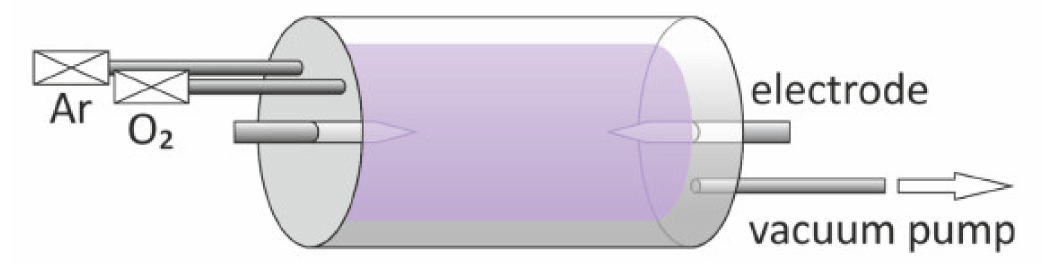
Figure 9. Schematic diagram of a custom-made plasma-enhanced horizontal tube furnace deposition system. The vacuum- sealed glass cylinder reactor has two electrodes with pointed ends from each side, and these two electrodes are used to ignite plasma. Adapted from [124], under the terms of the Creative Commons CC BY license.